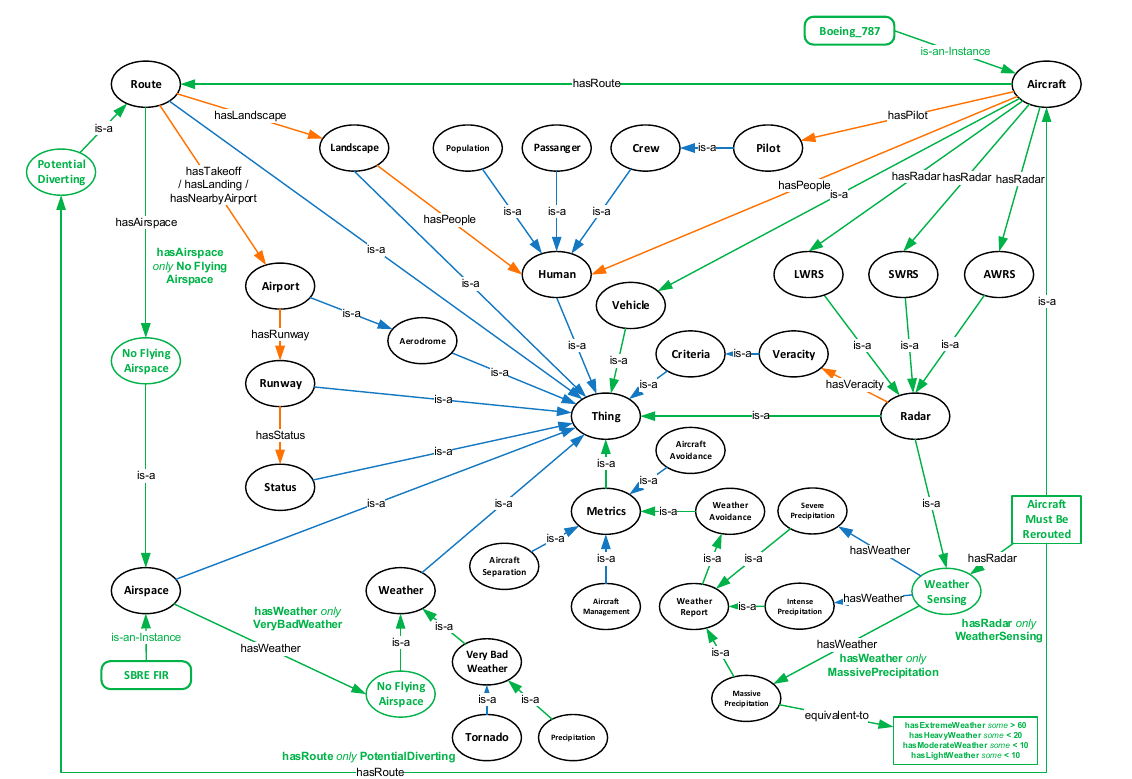
Figure 13. Reasoning behind the queries for airspace situation in Scenario 1.